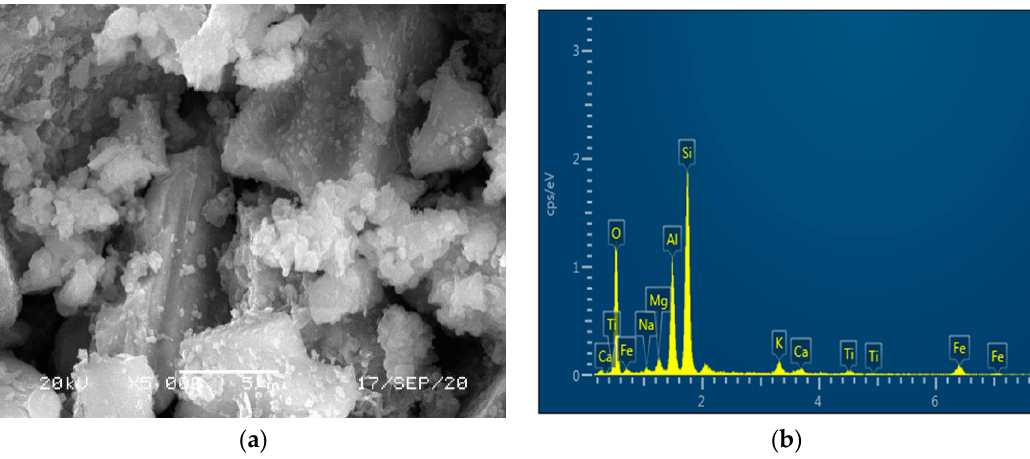
Figure 3. ( a ) SEM, ( b ) EDS. Micro characteristics of Portland cement.